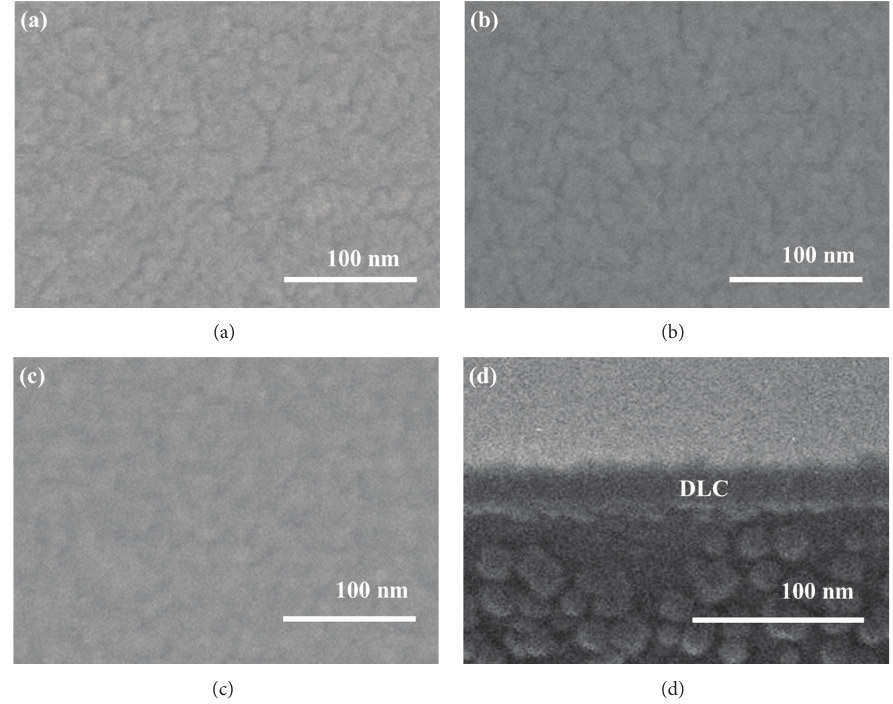
Figure 3: SEM images of DLC film are deposited on D263T glass substrate at room temperature by using RF magnetron sputtering technique. (a) SEM images of DLC film deposited referred to the specimen GD 9. (b) SEM images of DLC film deposited referred to the specimen GD 6. (c) SEM images of DLC film deposited referred to the specimen GD 3, and (d) the cross-section view shows the corresponding for image (c), which is 30nm thick DLC